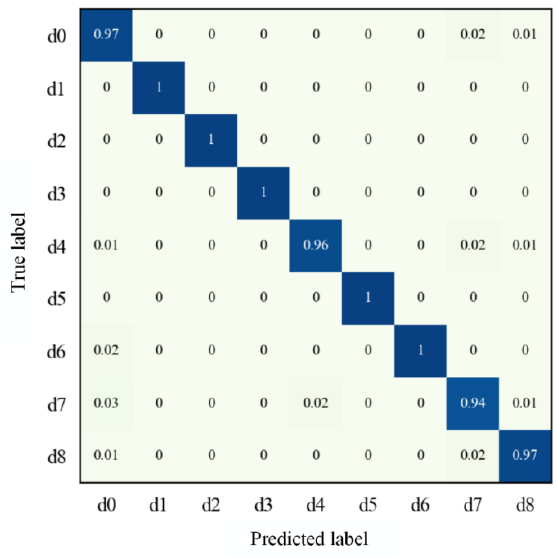
Figure 8. The details of the proportion of samples in each fault divided into other category.